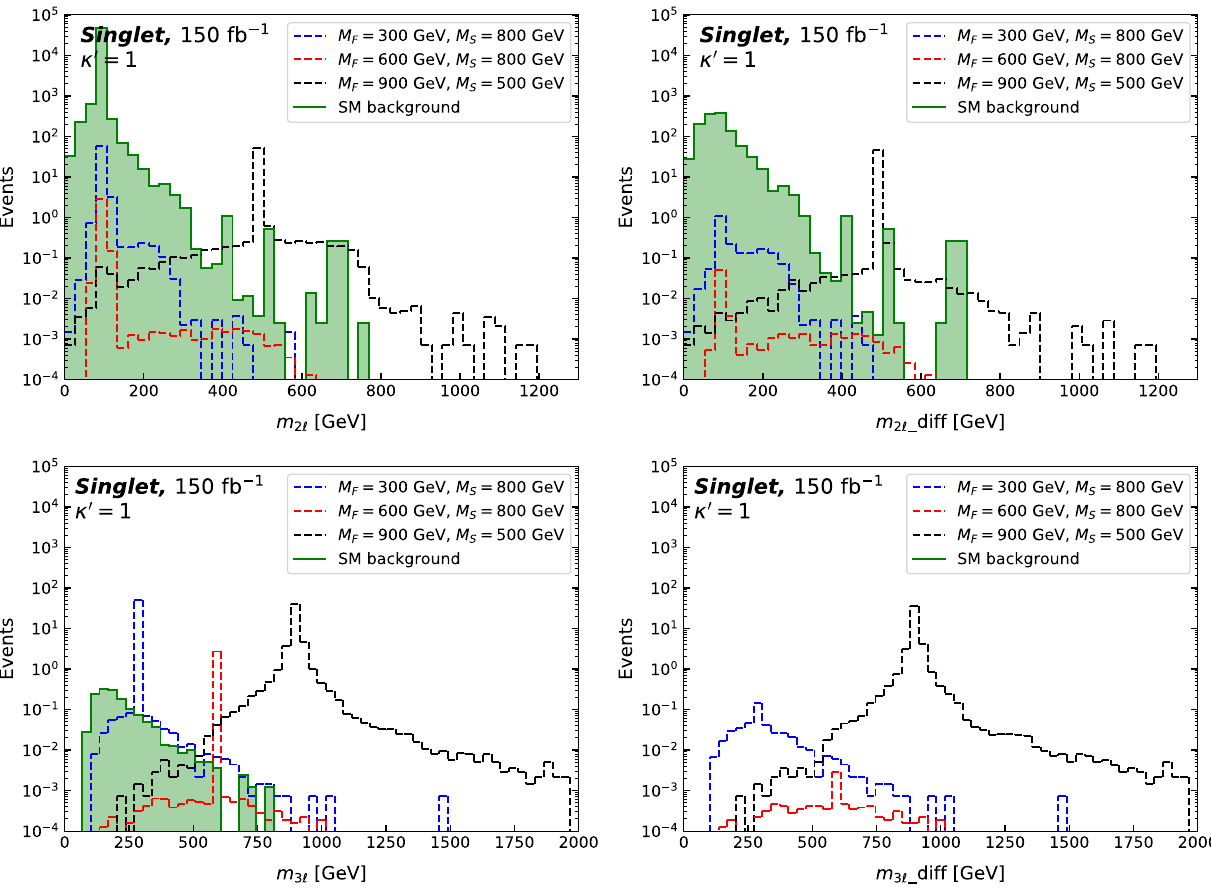
Fig. 14 Di- and trilepton invariant mass distributions m 2 (cid:5) , m 2 (cid:5) _diff, m 3 (cid:5) , and m 3 (cid:5) _diff for the singlet model with κ (cid:4) = 1, for the full Run 2 √ s = 13 TeV luminosity 150 fb − 1 and